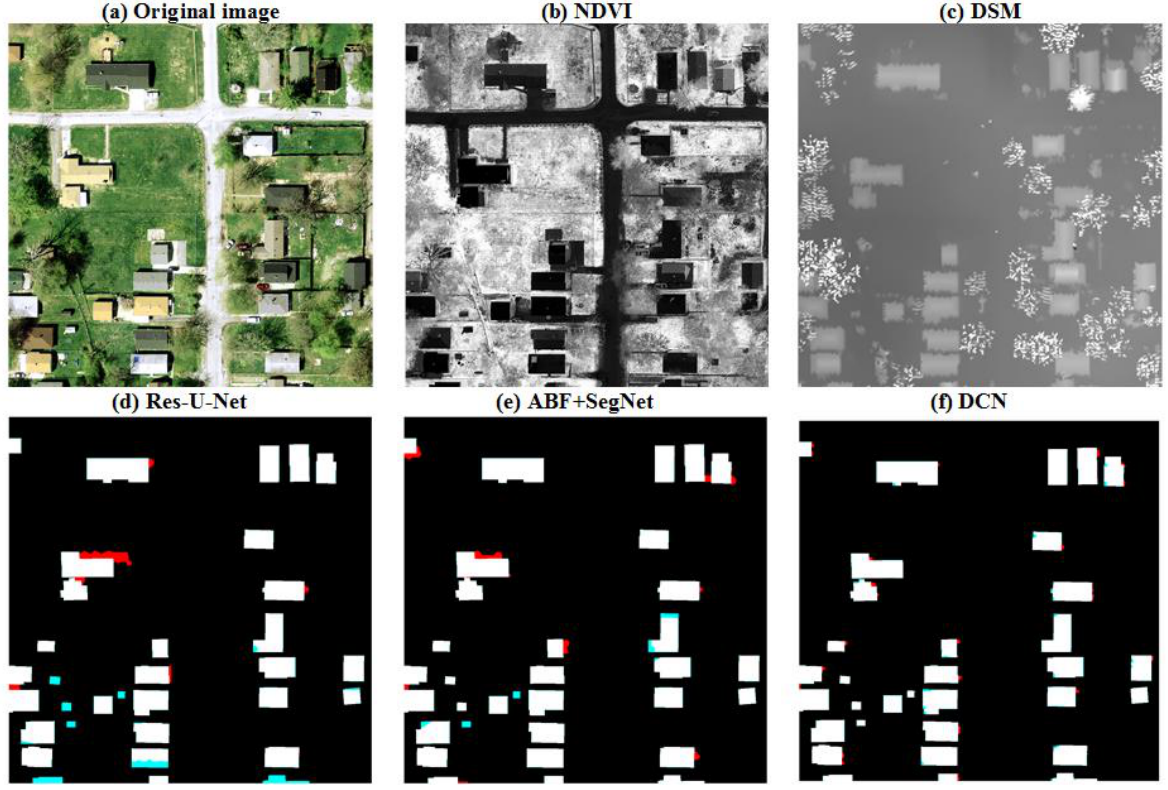
Figure 5. Comparison of BFE results using Res-U-Net, ABF+SegNet and DCN with ground truth in